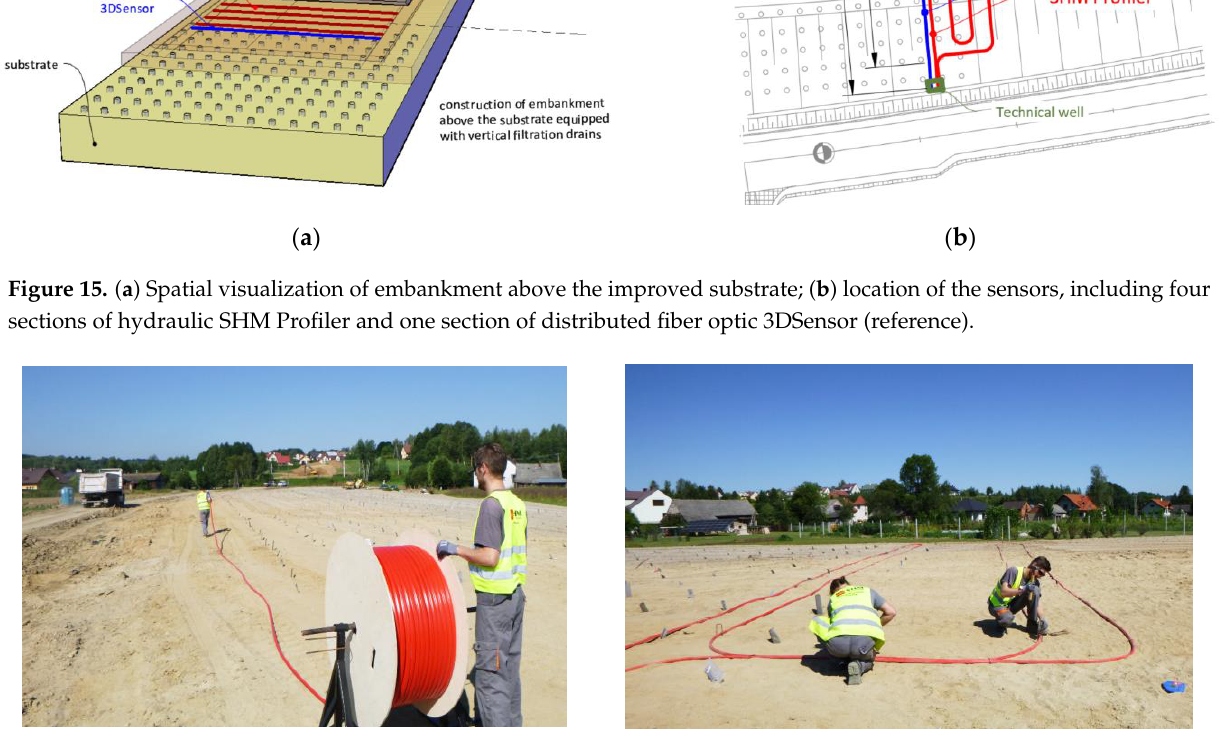
Figure 15. ( a ) Spatial visualization of embankment above the improved substrate; ( b ) location of the sensors, including four sections of hydraulic SHM Profiler and one section of distributed fiber optic 3DSensor (reference).